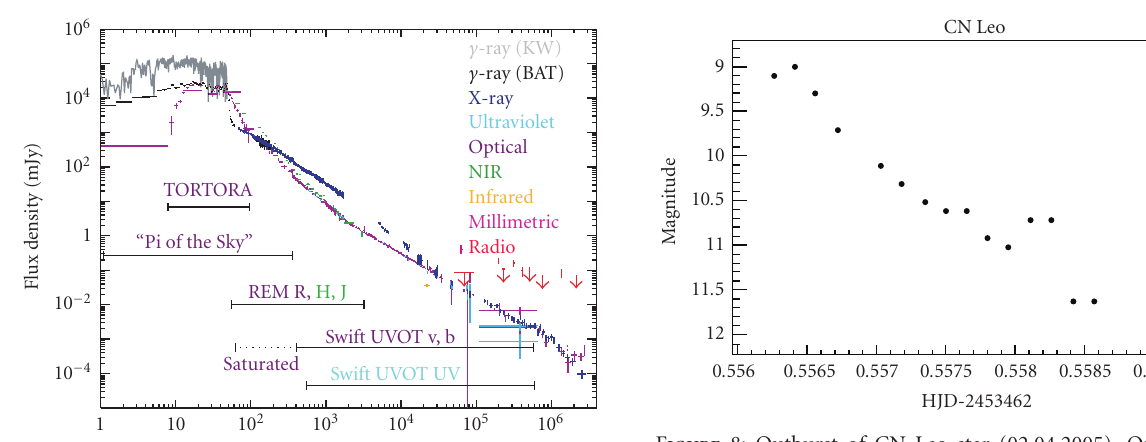
Figure 8: Outburst of CN Leo star (02.04.2005). On the image taken before the outburst, the star was not visible. During a few seconds its brightness raised by a factor of 100 and then faded away during several